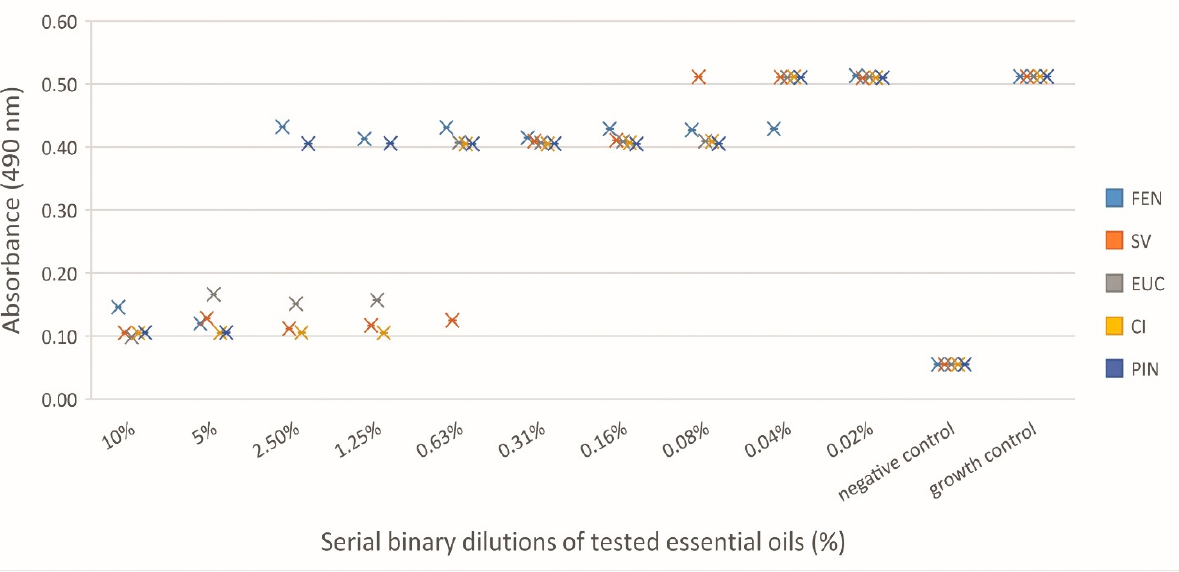
Figure 11. Graphical representation of the MCBE values for yeast strain Candida albicans ATCC 10231; FEN (fennel EO); SV (sage EO); EUC (eucalyptus EO); CI (thyme EO); PIN (pine EO).